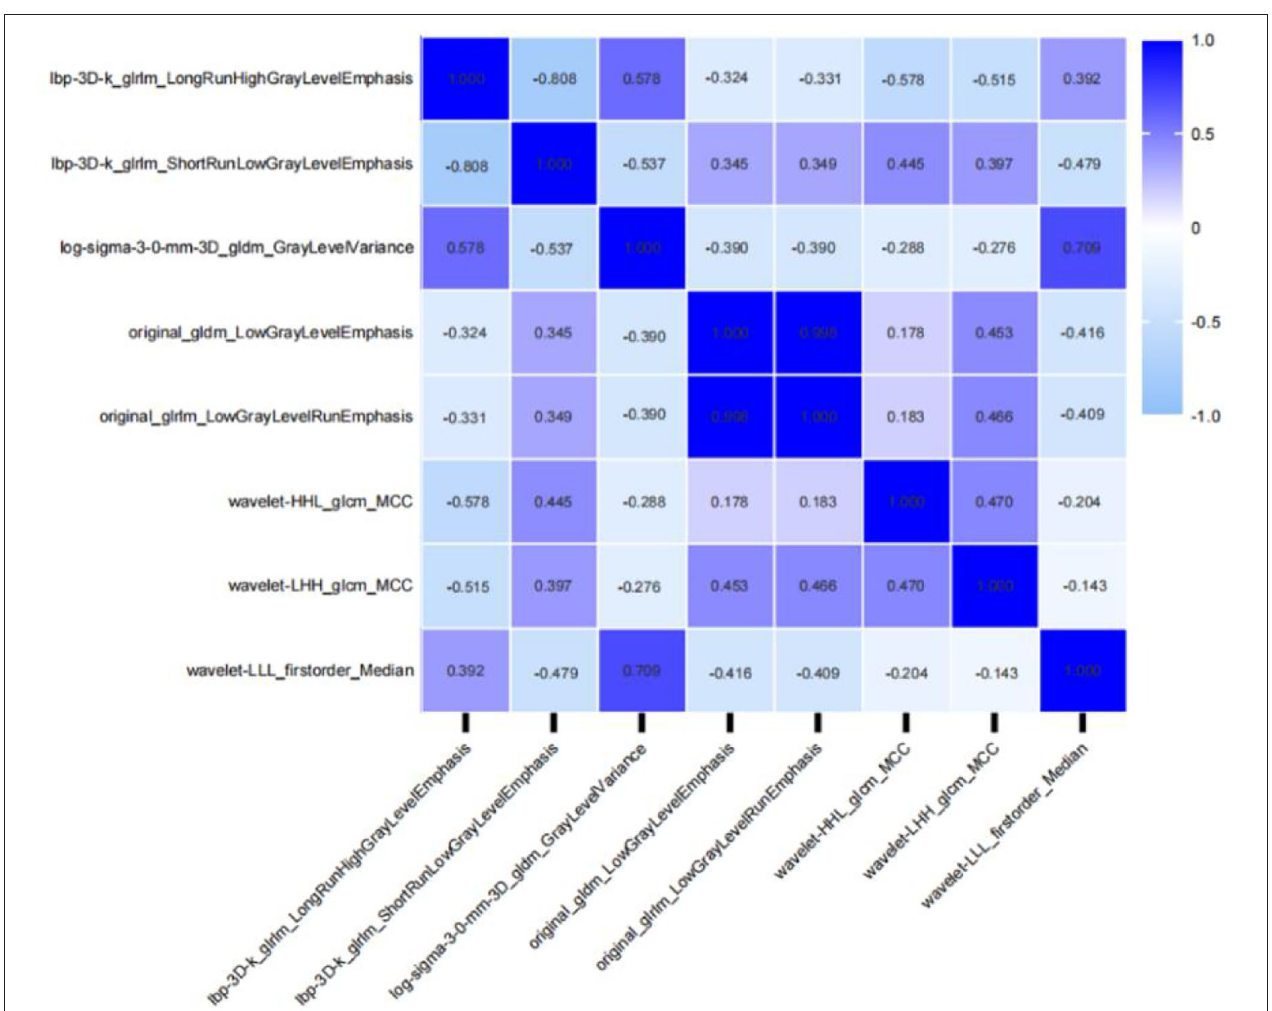
FIGURE 5 | Correlative heatmap between eight top-class radiomic features and Ki-67 levels. The values in the square lattices represent the magnitude of the R-value of a correlation analysis displayed by color difference.